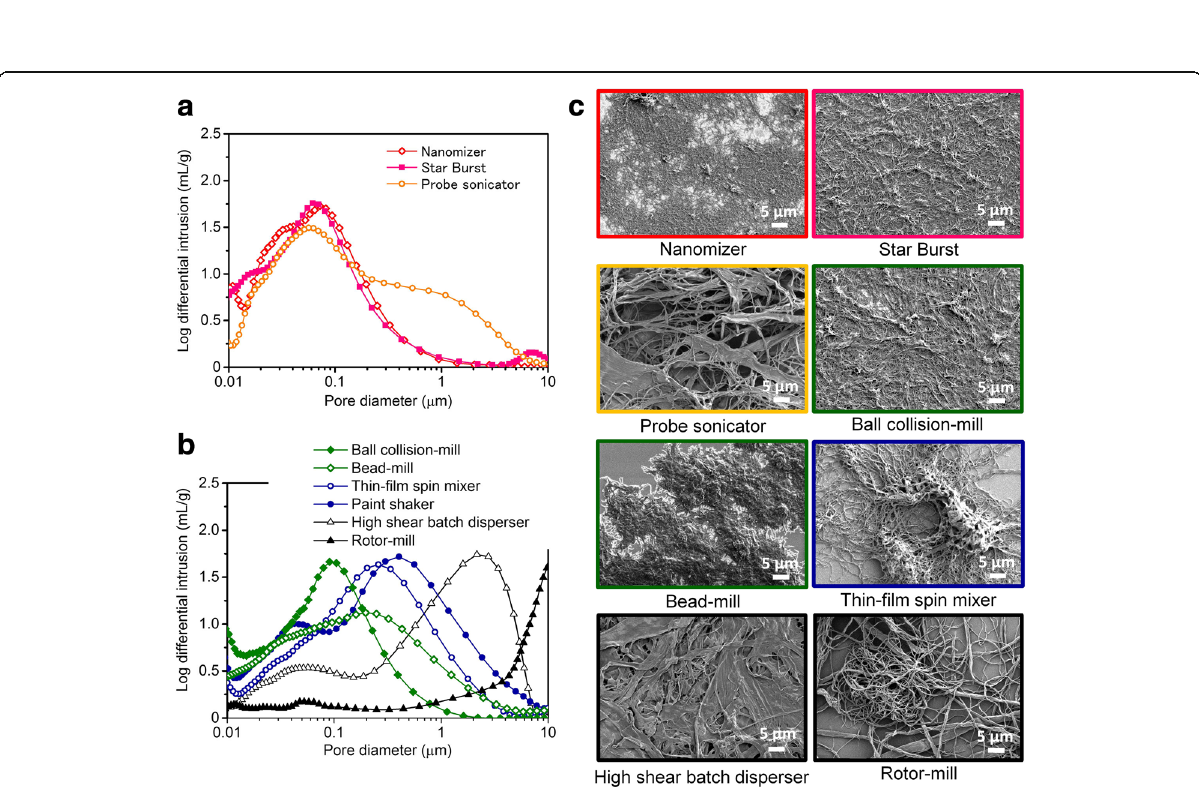
Fig. 4 Comparison of pores for SG SWNT Buckypapers made by different dispersion methods. a , b Their pore volume distribution as a function of pore diameter. c SEM images of the various SWNT bundle network structures spin-coated on flat surfaces